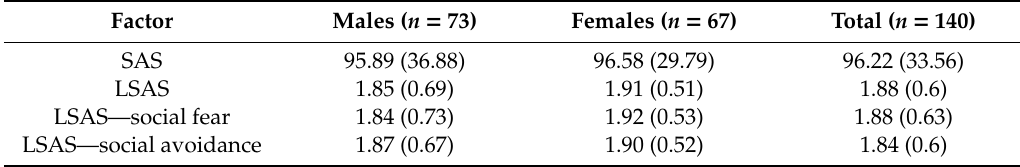
Table 1. Study 1—Questionnaire ratings in all participants mean (SD).